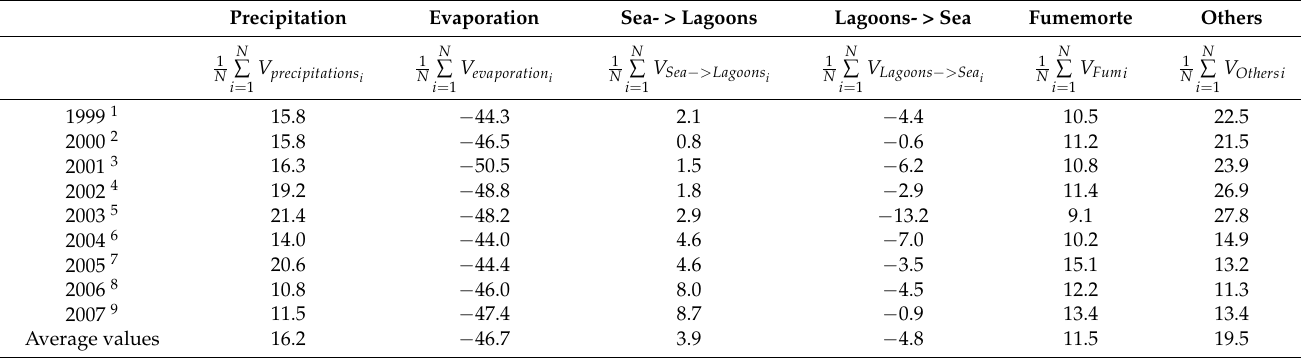
Table 1. Precipitation, evaporation, sea to lagoons, lagoons to sea, Fumemorte, and “Other” cumulative volumes calculated over nine periods with Equation (5). For the sake of readability, all volumes are divided by the number of days N of the period over which they have been calculated, and divided by 10 4 . (unity: 10 4 m 3 · day − 1 ). Each calculation period is close to the duration of a full year. The term “Others”, refers to all variations in the volume of the Vaccar è s Lagoon that are not due to precipitation, evaporation, Sea-lagoon exchanges, and Fumemorte inflows or outflows. The second line recalls the corresponding terms in Equation (5), divided by N